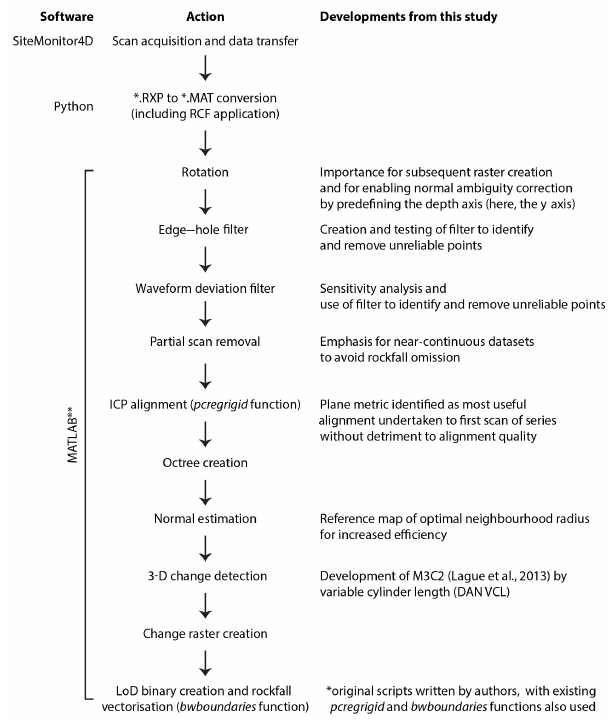
near-continuous monitoring change detection method. All stages following ASCII to MAT conversion were written in MATLAB®, with ICP alignment and rockfall vectorisation using the built-in functions pcregrigid and bwboundaries . Point clouds are initially rotated to become approximately planar across the x − z plane, en- abling the removal of points outside a tight bounding cuboid and rasterising of the point clouds of change. This rotation also en- ables an efficient solution to subsequent normal direction ambiguity, where the y component of each normal vector should always point out of the